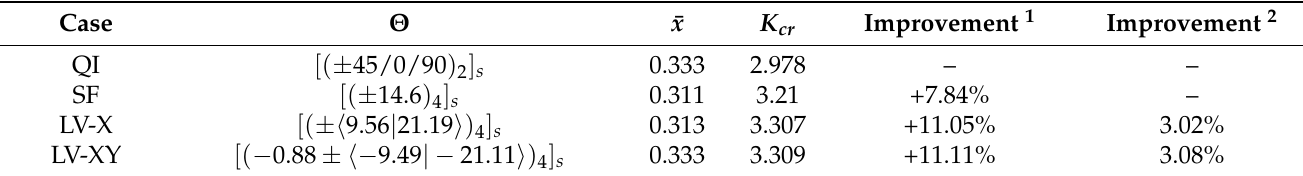
Table 5. Optimal designs and results of the stiffened plate with a central cutout subjected to uniform axial displacements (w/ AFP manufacturing constraints).